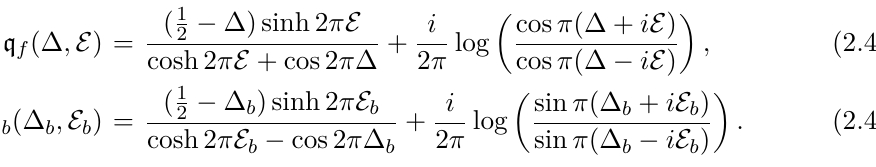
JHEP01(2023)098 . We also β